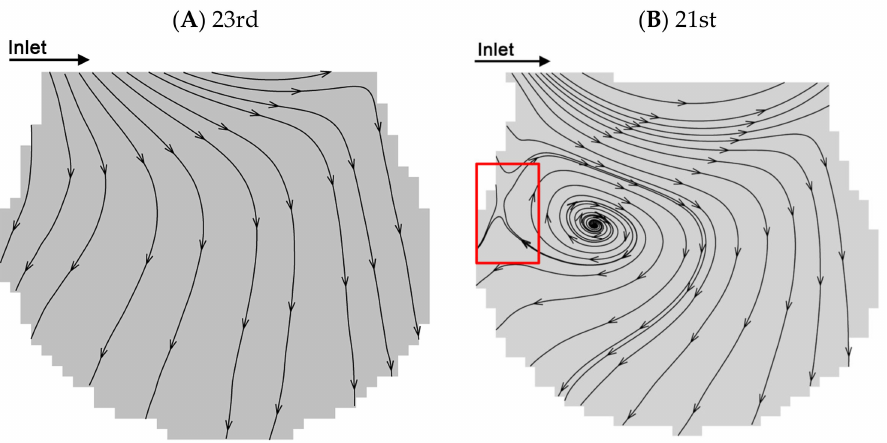
Figure 3. Flow patterns at the 21st and 23rd generations. ( A ) Radial flow pattern at the peak inspiration at the 23rd generation. ( B ) Recirculation flow pattern at the peak inspiration at the 21st generation. Figures ( A – B ) are adapted from the work of Lv et al. [38]. [Original citation]— Reproduced by permission of The Royal Society of